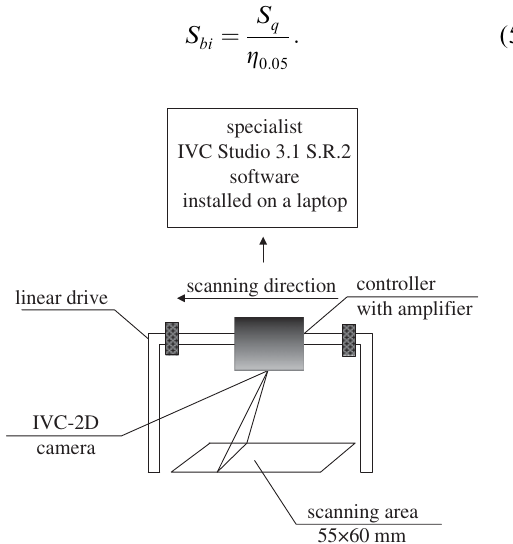
Fig. 4. Schematic of the non-destructive impulse response technique Fig. 5. Schematic of the non-destructive optical